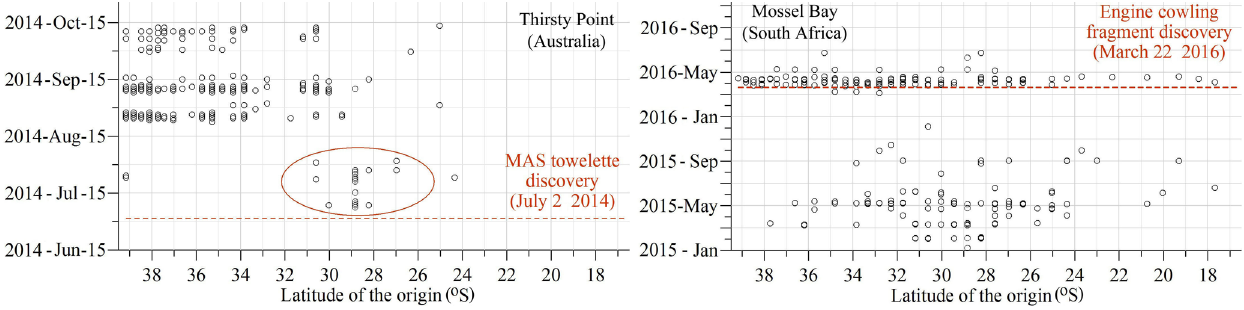
N SA = 5 to the number of particles landed in South